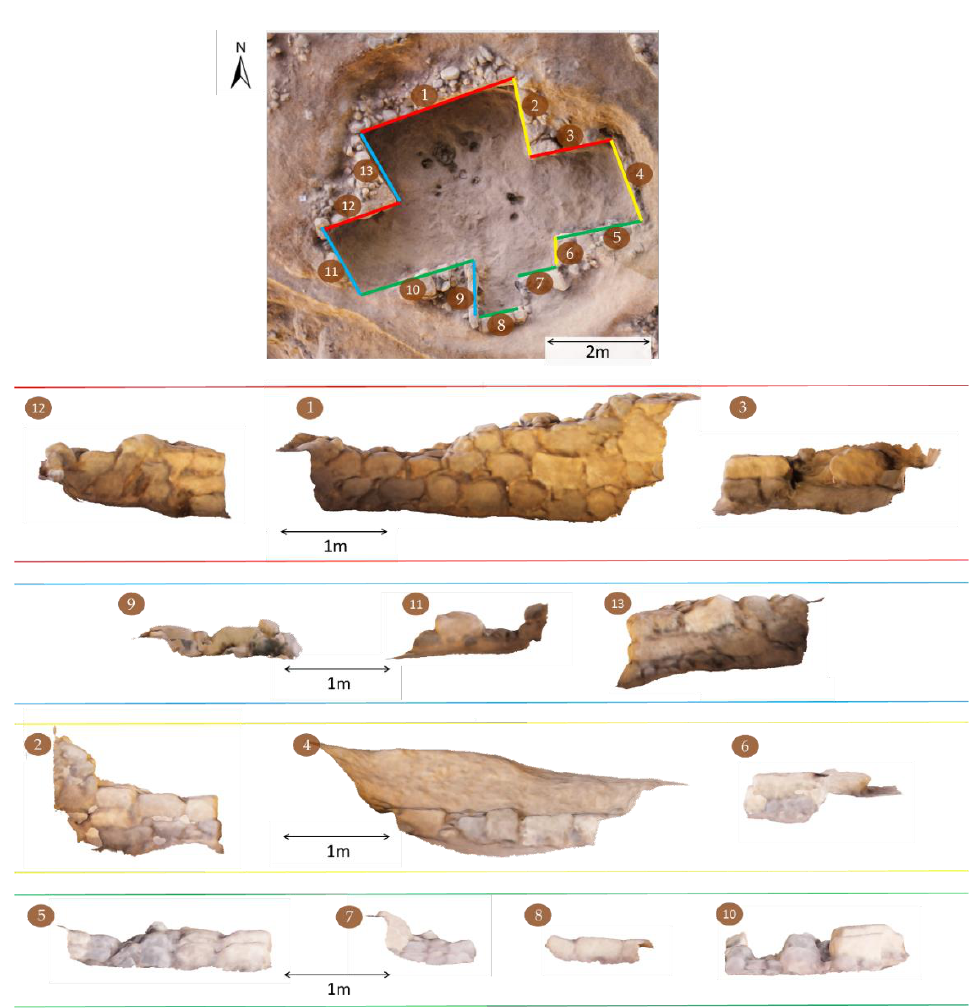
Figure 11. Orthoimage of the rest of the house detailed in Figure 9 and orthoimages of the walls that comprise it.